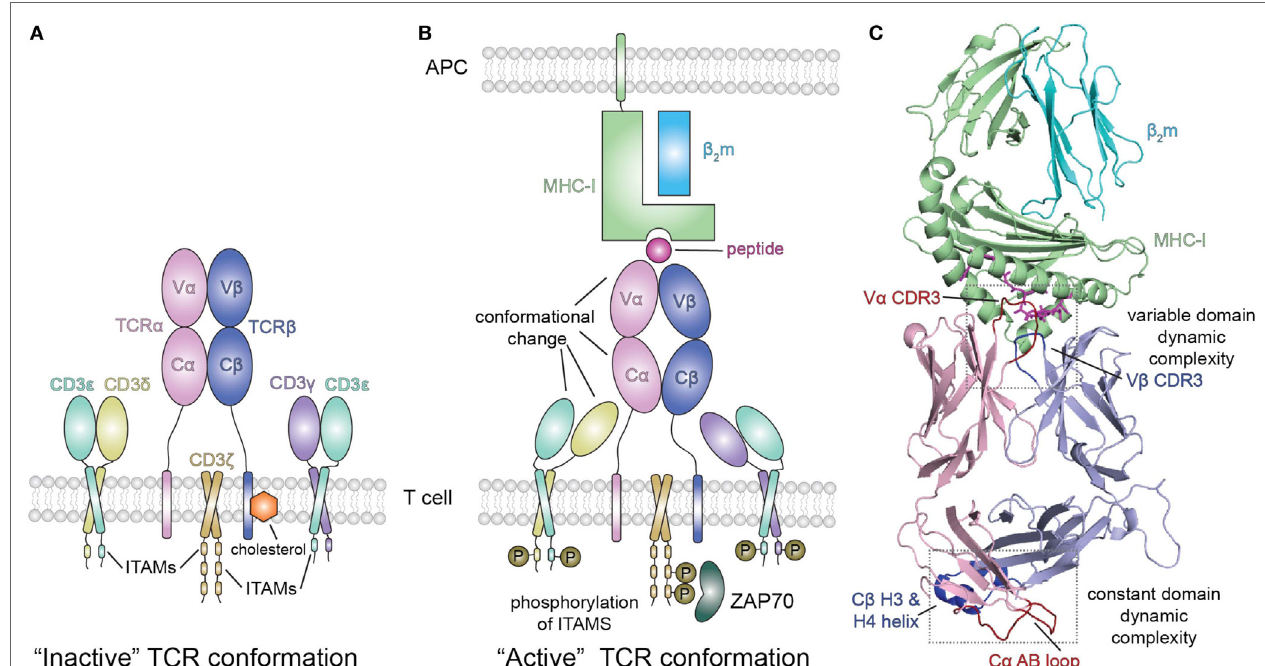
FiGURe 3 | Peptide/MHC-I (pMHC-I) induced allosteric communication model for signaling of the TCR-CD3 complex. (A) In the absence of peptide–MHC-I ligand, cholesterol associates with the T cell receptor (TCR) β chain and maintains the TCR/CD3 complex in an “inactive” TCR conformation. The TCR αβ heterodimer is non-covalently associated with the CD3 γε and δε subunits as well as the ζζ homodimer. (B) Binding of pMHC-I molecules with the membrane distal variable domains (V α , V β ) of the αβ TCR receptor has been proposed to allosterically modulate the structure and dynamics of the membrane proximal constant domains (C α , C β ) which are sensed by the associated CD3 molecules resulting in an “active TCR.” This pMHC-I/TCR mediated conformational change in CD3 allows for phosphorylation (P) of downstream immunoreceptor tyrosine-based activation motifs (ITAMs) that recruit proteins involved in signaling, such as ZAP70. Abbreviation: APC, antigen-presenting cell. (C) Structural view of the extracellular domain of the bound pMHC-I/TAP-binding protein, related complex (PDB ID 5IVX). Gray dotted boxes highlight regions of dynamic complexity that are proposed to be involved in the allosteric communication